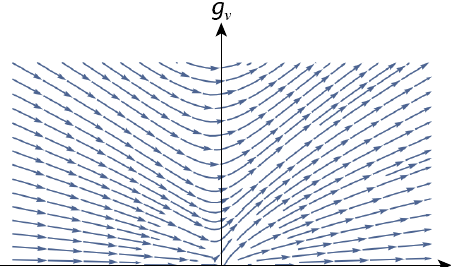
( k )( 1 + A ( g ∗(cid:48) ) 2 )] against ln [ 1 / | k | ] , where G n n ) 2 = 0,1 / 2,2, and 5. n